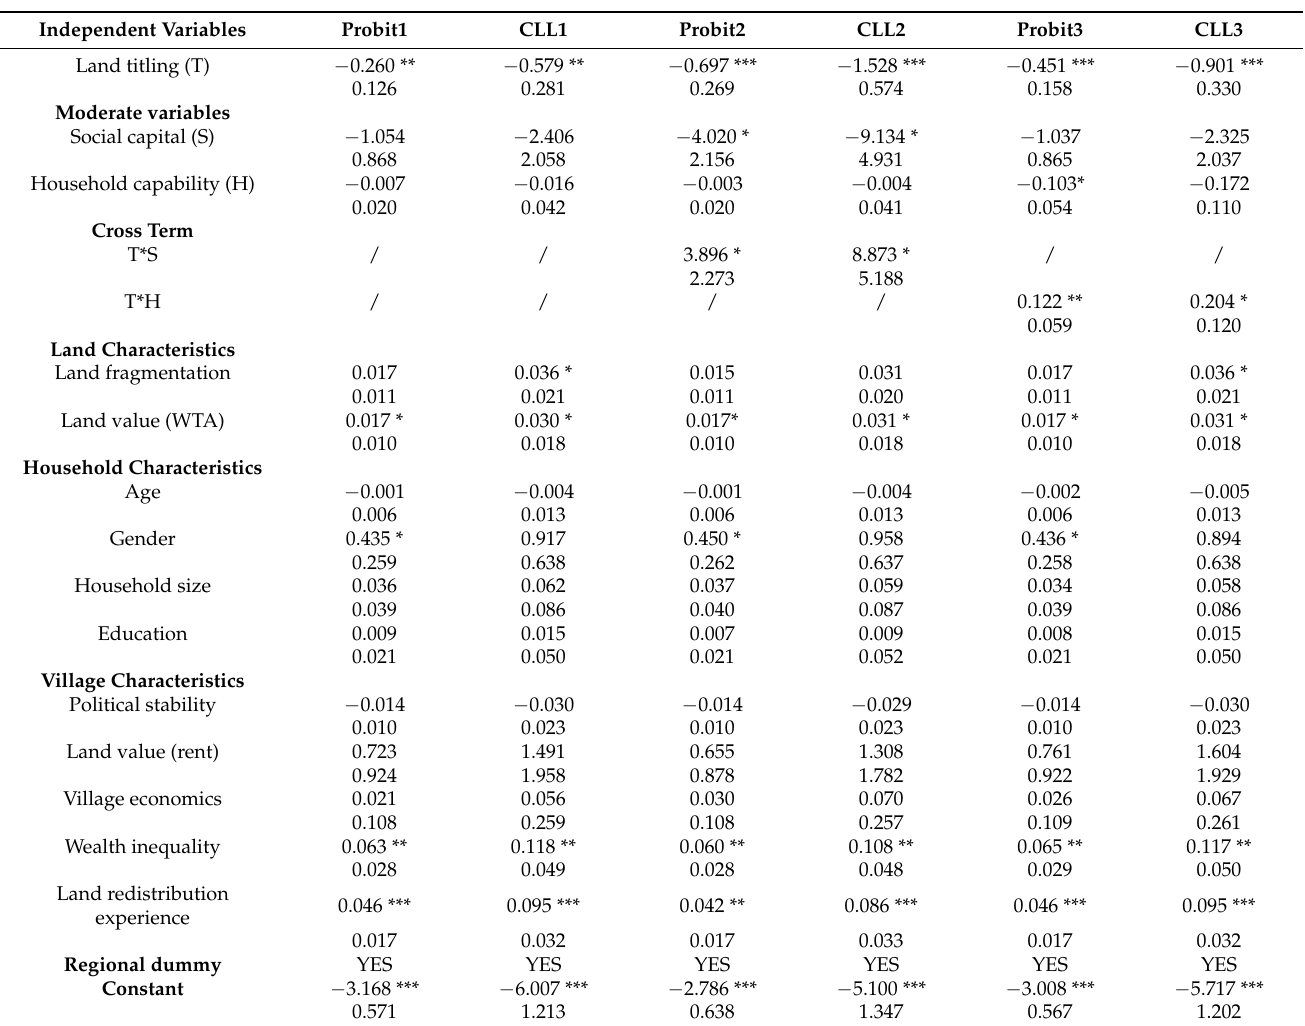
Table 3. Empirical regression results of both probit and CLL models.